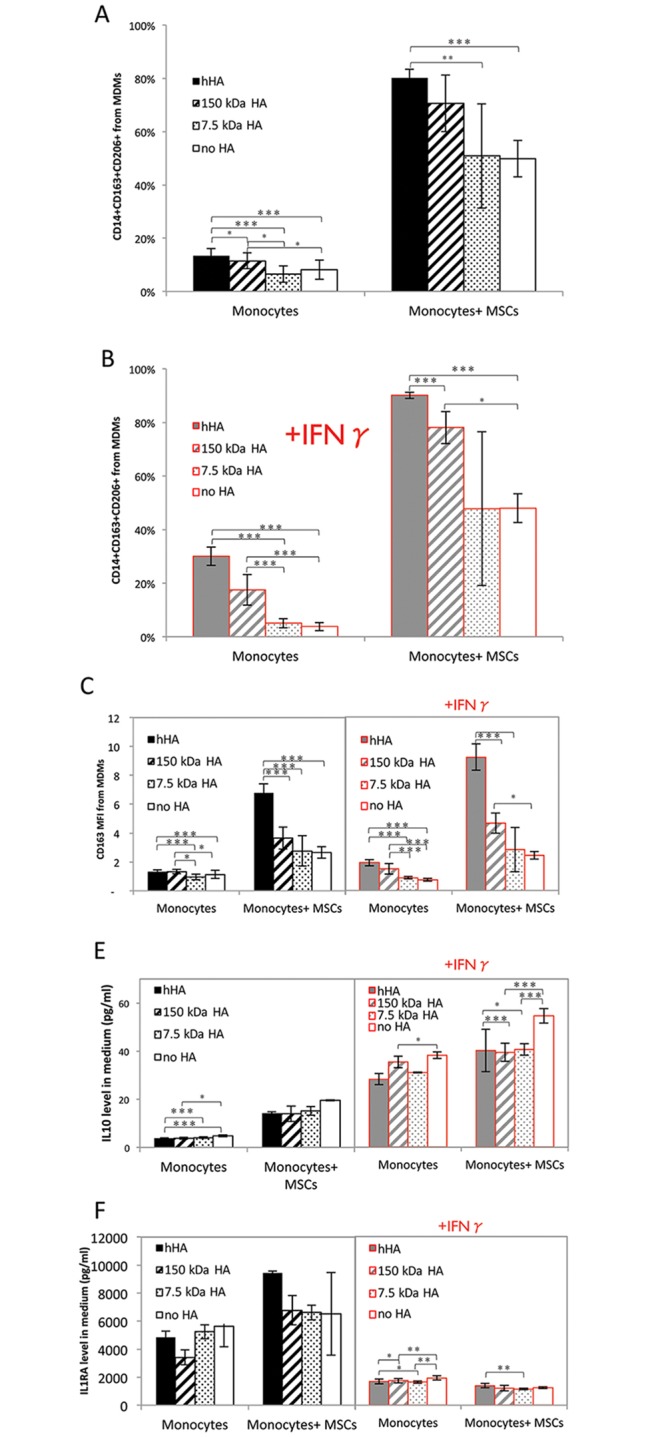
Effect of different MWs of HA on MSC-mediated induction of M2 MDMs.(A) and (B) Frequency of M2 MDMs within the whole MDM population. (C) mean fluorescence intensity (MFI) levels of CD163 from whole MDM population. All data shown is from one representative experiment; additional data from 3 MSC donors is shown in S9 Fig. (D) and (E) Levels of secreted IL10 and IL1RA as measured by ELISA. Solid filled bars stand for hHA; hatched bars, 150 kDa HA; dotted bars, 7.5 kDa HA and empty bars, no HA. Black color, normal conditions and gray color with red frame, IFNγ-supplemented conditions. Statistical differences account for data from three independent experiments; each with MSCs and monocytes from different donors in allogeneic co-cultures. Each bar indicates the mean of triplicates. Error bars represent 95% CI. * p<0.05, ** p<0.01 and ***<0.001.